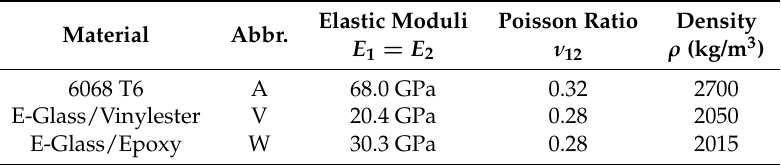
Table 1. Material